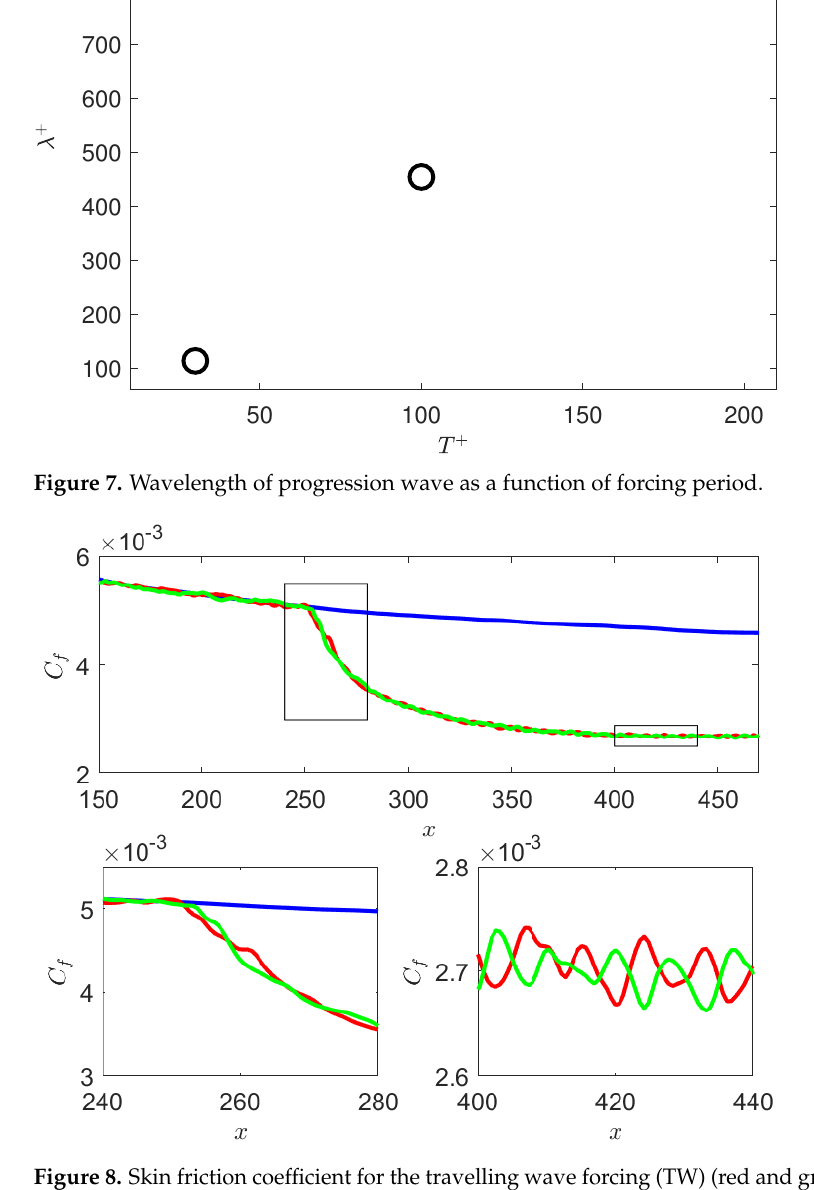
Figure 8. Skin friction coefficient for the travelling wave forcing (TW) (red and green are two separate phases, 90 ◦ apart) together with skin friction for the reference boundary layer